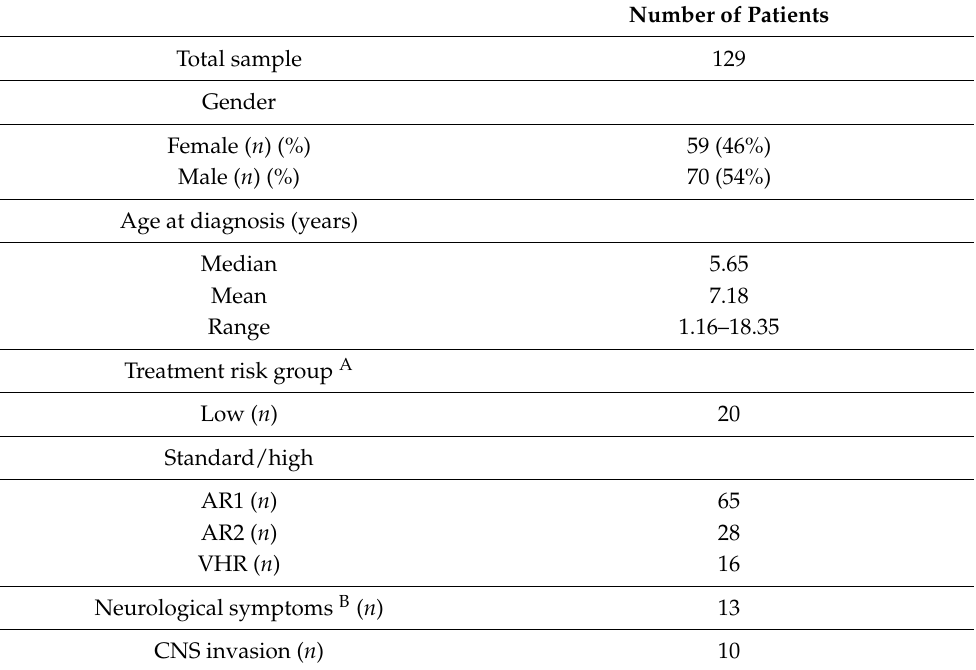
Table 1. Patient